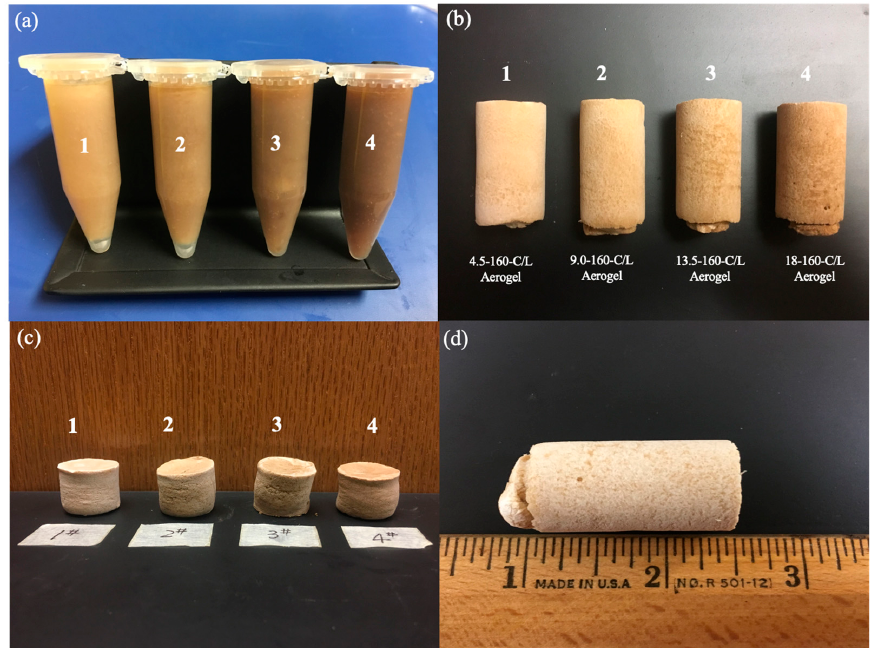
Figure 1. Photographic images of ( a ) CNF/nano-lignin mixture, ( b ) CNF/nano-lignin aerogel (at different nano-lignin values 4.5 wt%, 9.0 wt%, 13.5 wt%, and 18 wt%) and ( c ) CNF/nano-lignin aerogels